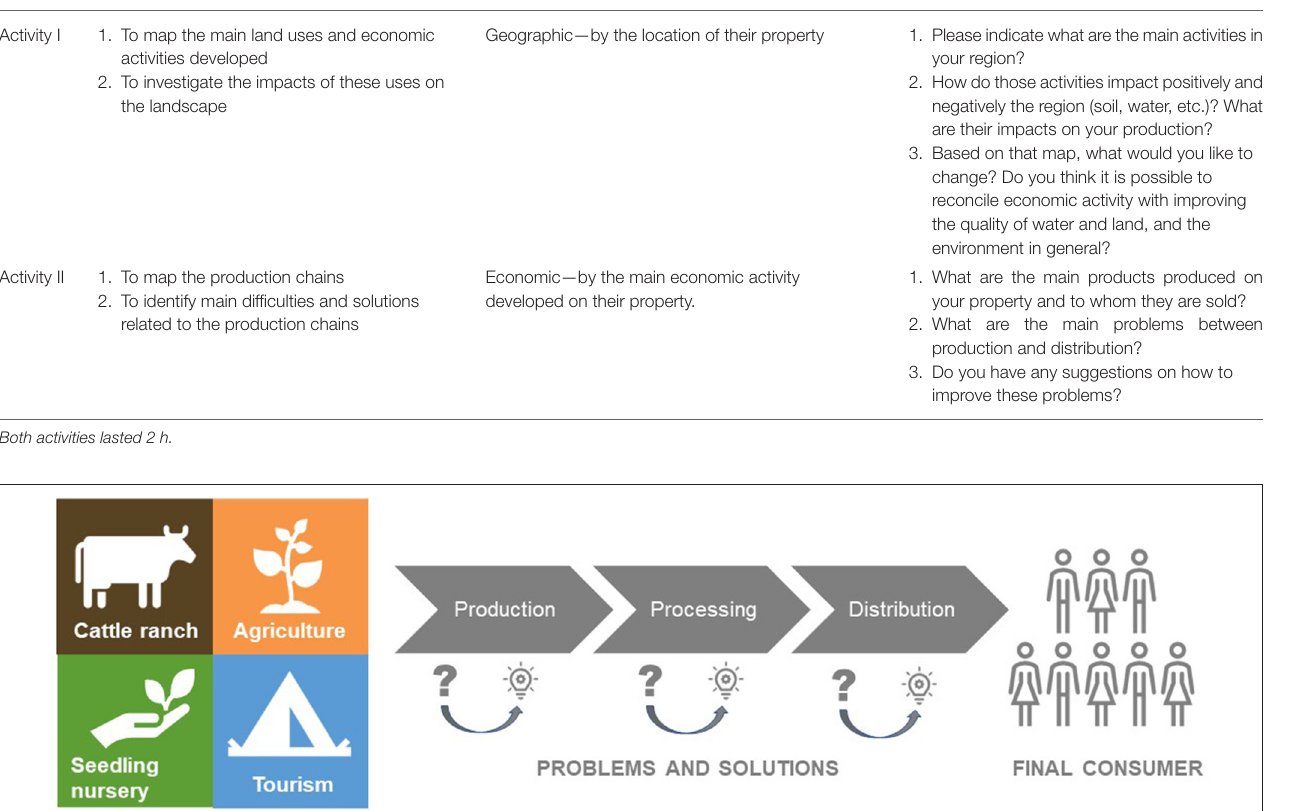
FIGURE 2 | Representation of the main links of the production chain used in activity II of the